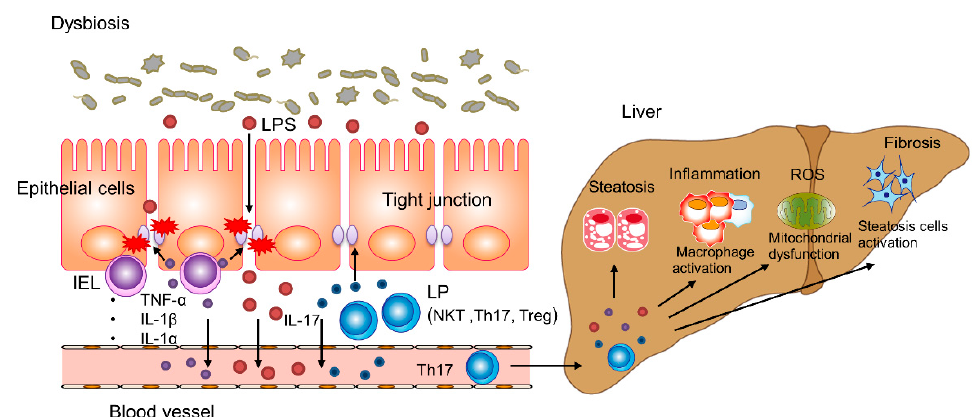
Figure 2. Interaction between dysbiosis-induced alteration of the intestinal mucosal barrier and progression of NASH. Tight junction dysfunction is induced by LPS, and proinflammatory cytokines are produced by intraepithelial lymphocytes (IELs) and the lamina propria (LP), enhancing intestinal epithelial permeability and inducing metabolic endotoxemia followed by hepatic inflammation, steatosis, and fibrosis. Intestinal IL-17 protects tight junctions in the gut, and the serum IL-17 level is increased in NASH patients. The secretion of IL-17 by Th17 cells stimulates monocytes, Kupffer cells, biliary epithelial cells, and stellate cells to secrete proinflammatory cytokines and chemokines, inducing inflammation in the liver.